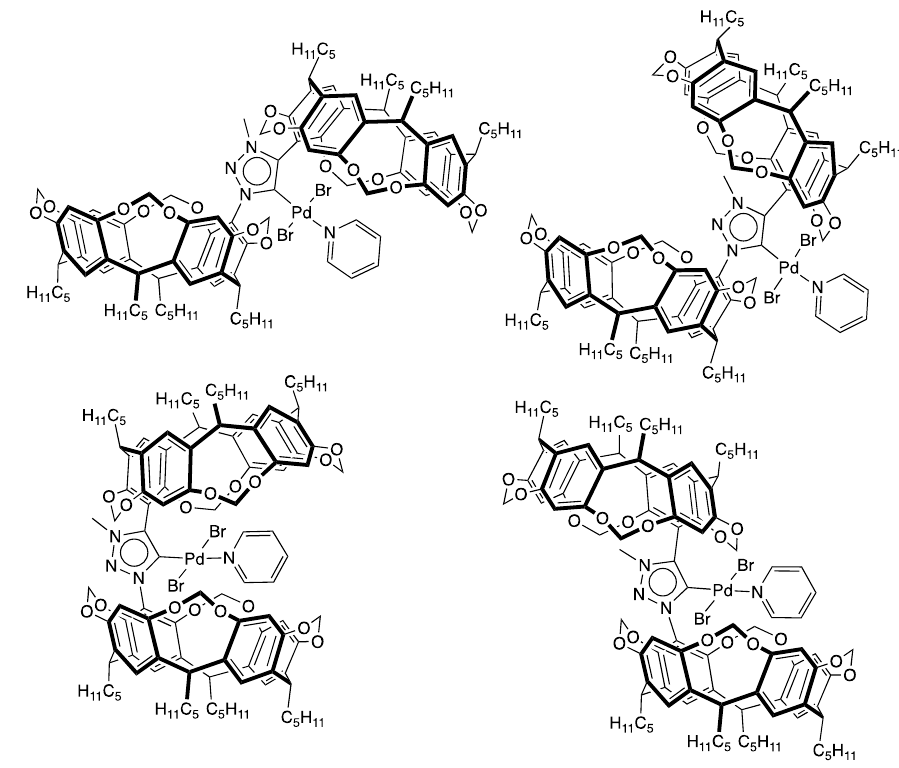
Figure 3. Rotational conformers of complex 10 .